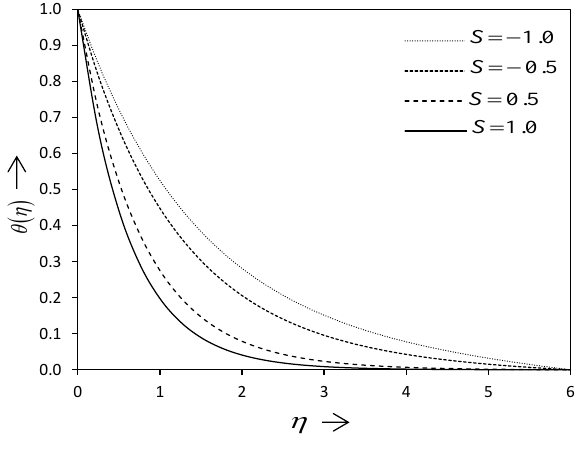
Figure 5. Temperature profiles against  for various values of S with